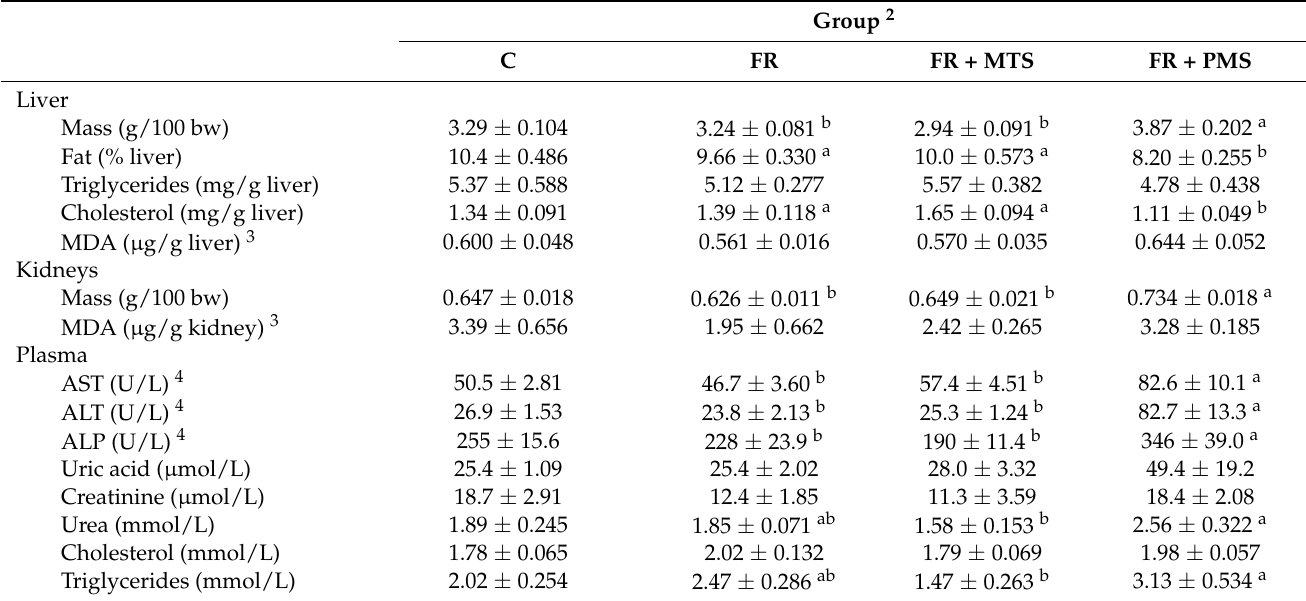
Table 4. Internal organ functions and lipid metabolism in rats after 4 weeks of feeding with a fibre-rich (FR) diet containing milk thistle seeds (MTSs) or pot marigold seeds (PMSs) 1